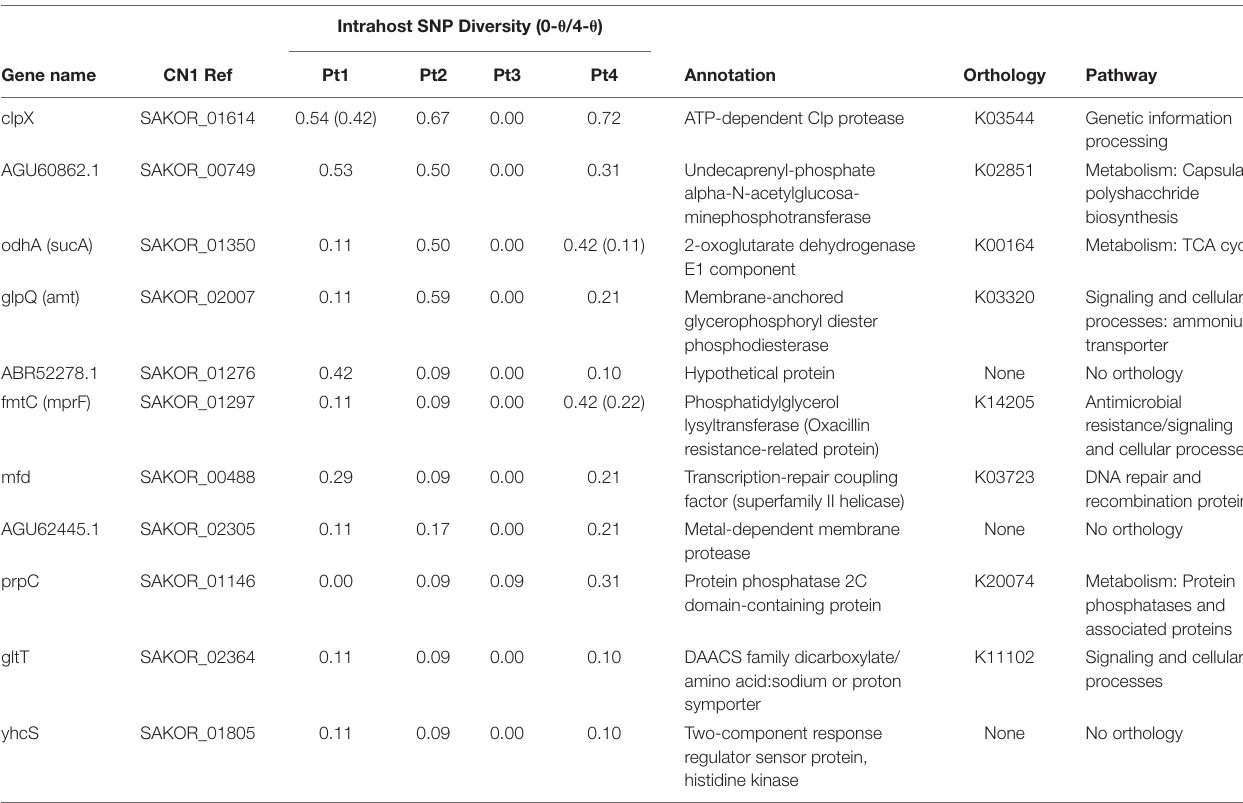
TABLE 3 | Core genome clusters of orthologous groups (COGs) that contained nucleotide diversity among three clonal intrahost